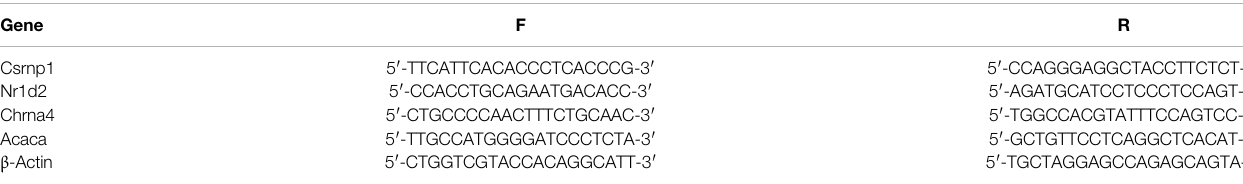
TABLE 1 | Primers for RT-qPCR